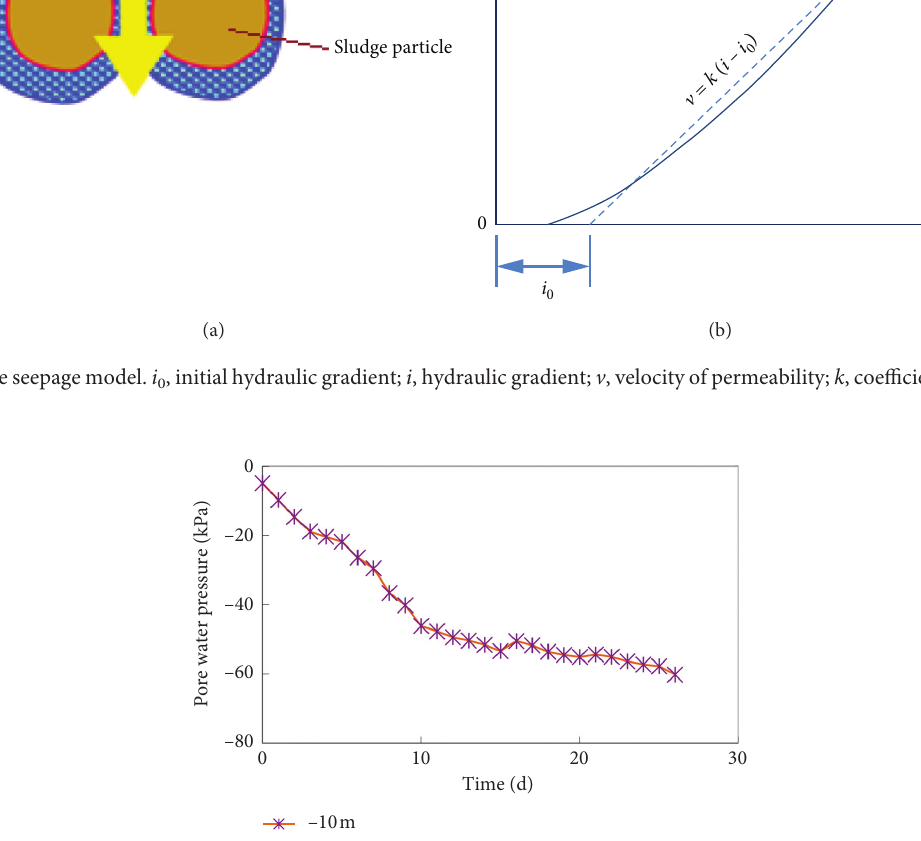
Figure 17: The excess pore pressure with traditional vacuum preloading (10m